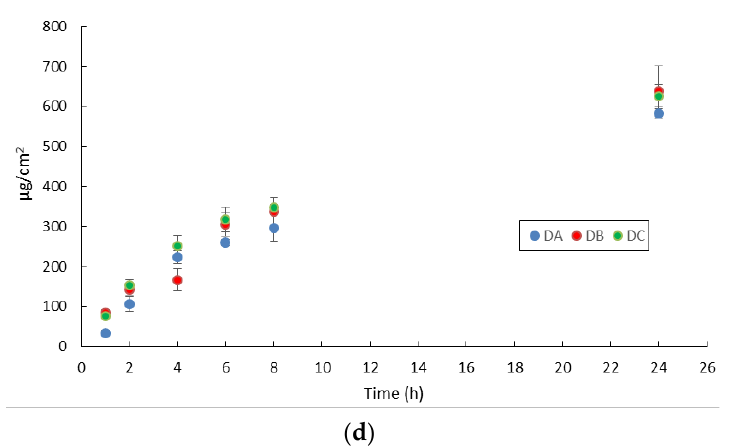
Figure 3. Idebenone release from formulations ( a ) AA, AB, AC; ( b ) BA, BB, BC; ( c ) CA, CB, CC; ( d ) DA, DB, DC.